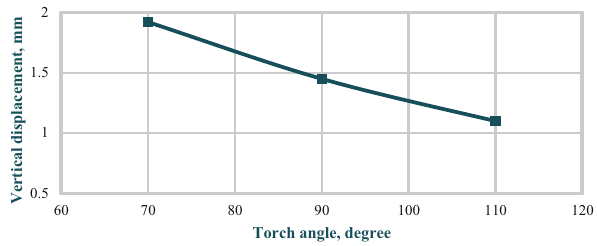
Figure 2: The weaving motion of the welding electrode. Figure 3: The variation of the angular distortion with the torch